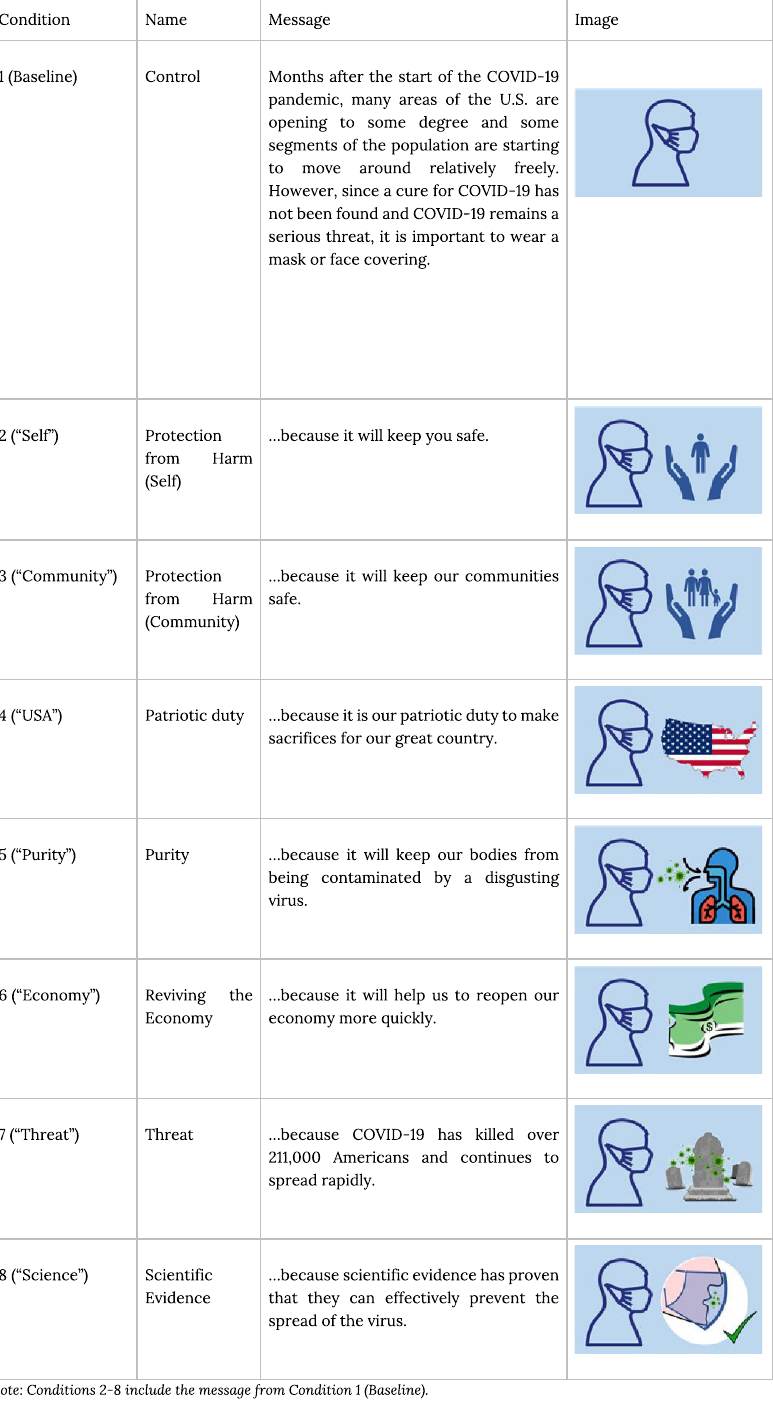
Table 2. Original nudge conditions Gelfand et al. 11